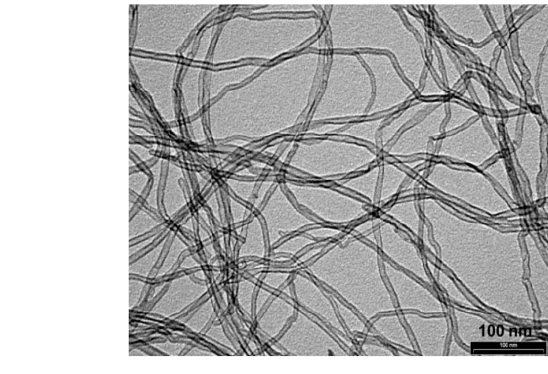
Figure 1. The morphology of multiwall CNTs by ( a ) SEM and ( b ) TEM images.